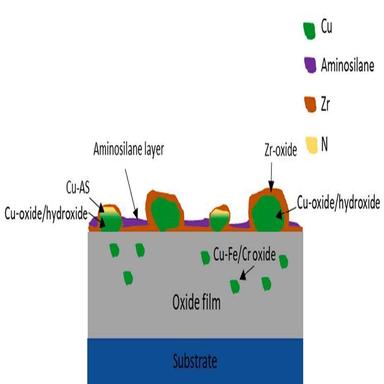
Schematic illustration of the composition of hybrid Zr–As conversion coating on AHSSS.